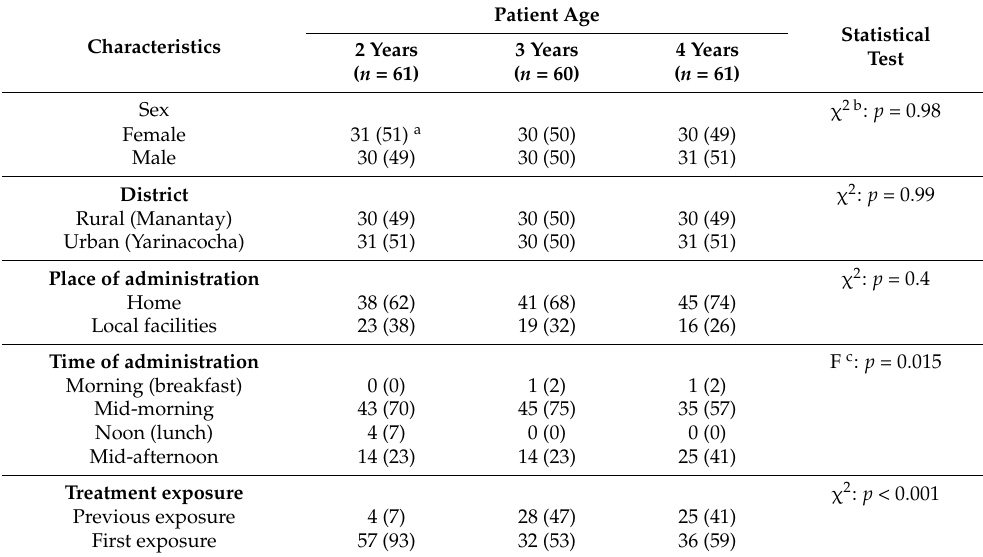
Table 1. Characteristics of the 182 patients included in the study, stratified by patient age.